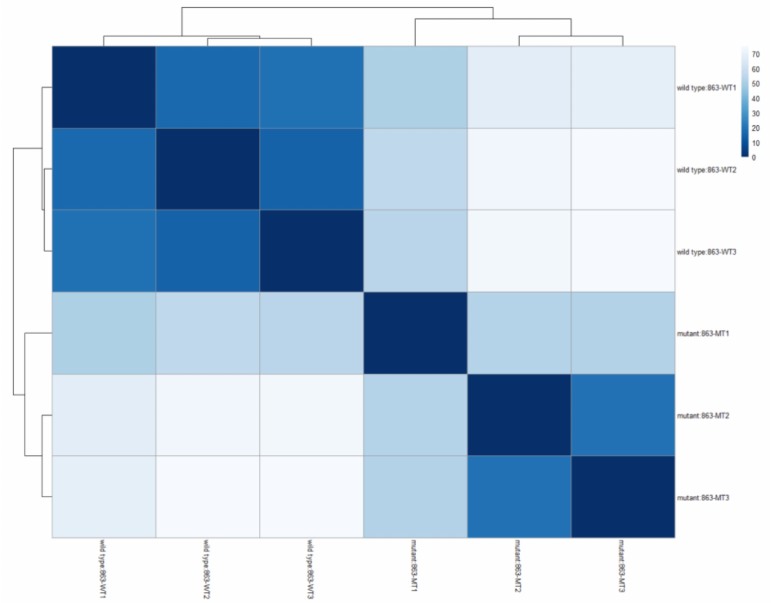
Figure 8. A heatmap showing sample-to-sample Euclidean distances computed from the regularized log transformation. This heat map shows that the wild type and QS-deficient mutant were clustered in respective groups, which indicates a distinct difference in the expression of various